Question: Write a caption explaining this figure to a reader.
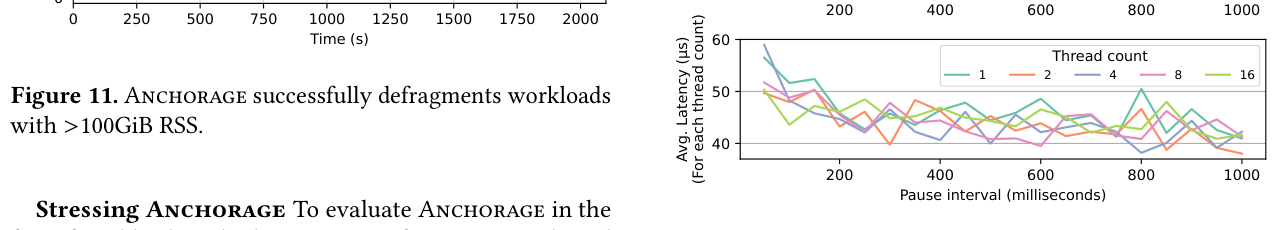
Answer: Latencies in memcached vary based on the pause time, and there is no trend between latency and number of threads.